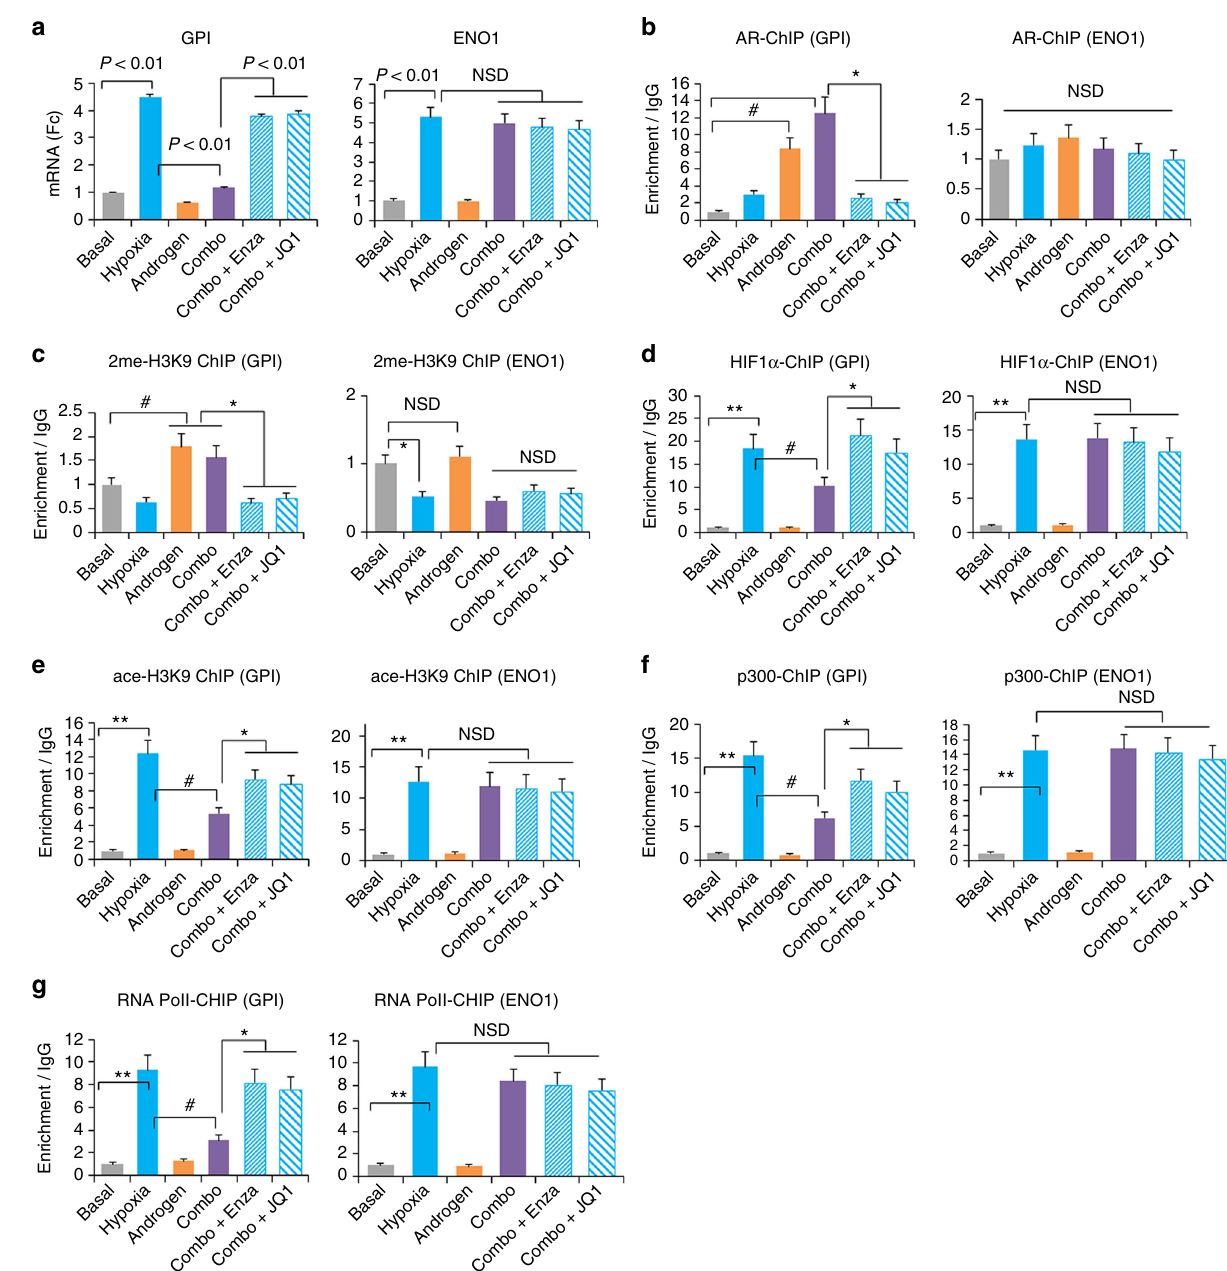
Fig. 4 Androgen/AR epigenetically attenuates HIF1-mediated GPI transcription in hypoxia. LNCaP-AdtHs cells were treated with basal (CSS media), 1% O2 (hypoxia), 1 nM R1881 (androgen), hypoxia + androgen (Combo), or Combo + androgen/AR-targeted agents (enzalutamide or JQ1) for 48 h. Afterwards, gene expressions (GPI and ENO1) were determined by qRT-PCR and the enrichment of epigenetic compositions at the HRE of GPI and ENO1 promoters was determined by ChIP. a The mRNA level of GPI and ENO1 at the indicated conditions. b Levels of AR enrichment at the HRE regions in GPI and ENO1 promoters. c Levels of 2-methyl histone 3 lysine 9 enrichment at the HRE regions in GPI and ENO1 promoters. d Levels of HIF1 α binding to the HRE regions in GPI and ENO1 promoters. e Levels of acetylation of histone 3 lysine 9 enrichment at the HRE regions in GPI and ENO1 promoters. f Levels of p300 enrichment at the HRE regions in GPI and ENO1 promoters. g Levels of RNA polymerase II enrichment at the HRE regions in GPI and ENO1 promoters. All values were mean ± s.d. relative to the basal condition, n = 3, # , * P < 0.05, ** P < 0.01, NSD, two-sided t